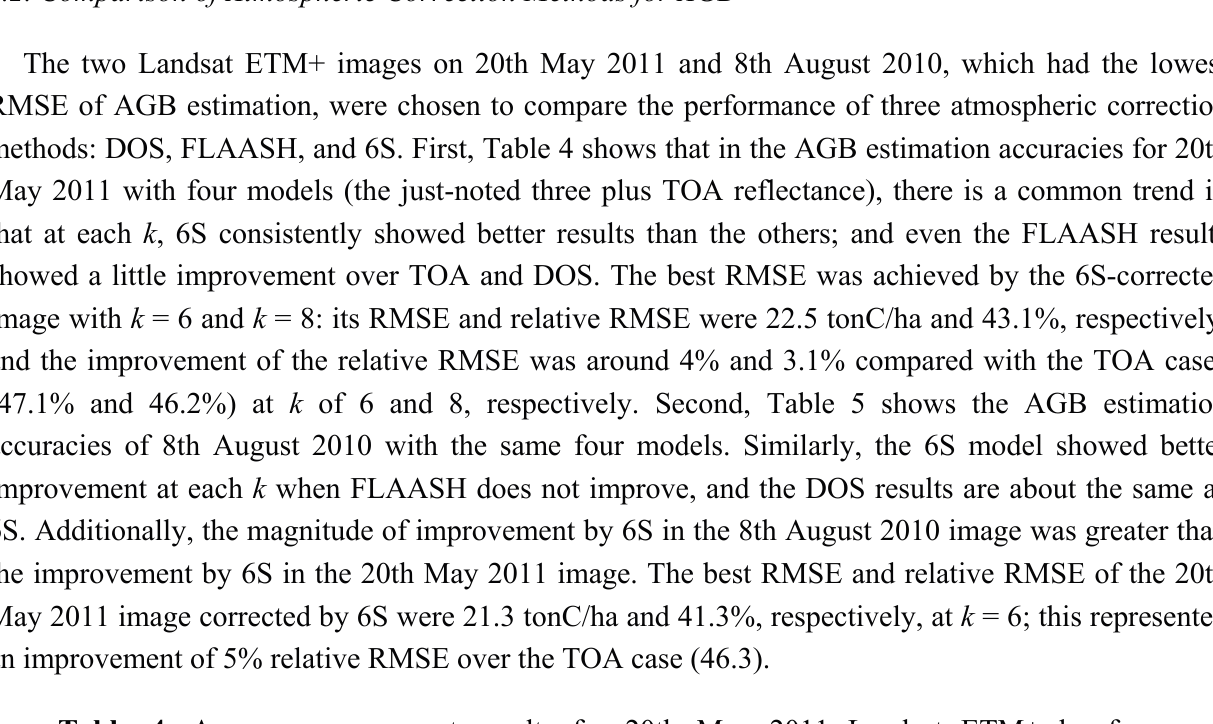
Table 4. Accuracy assessment results for 20th May 2011 Landsat ETM+ by